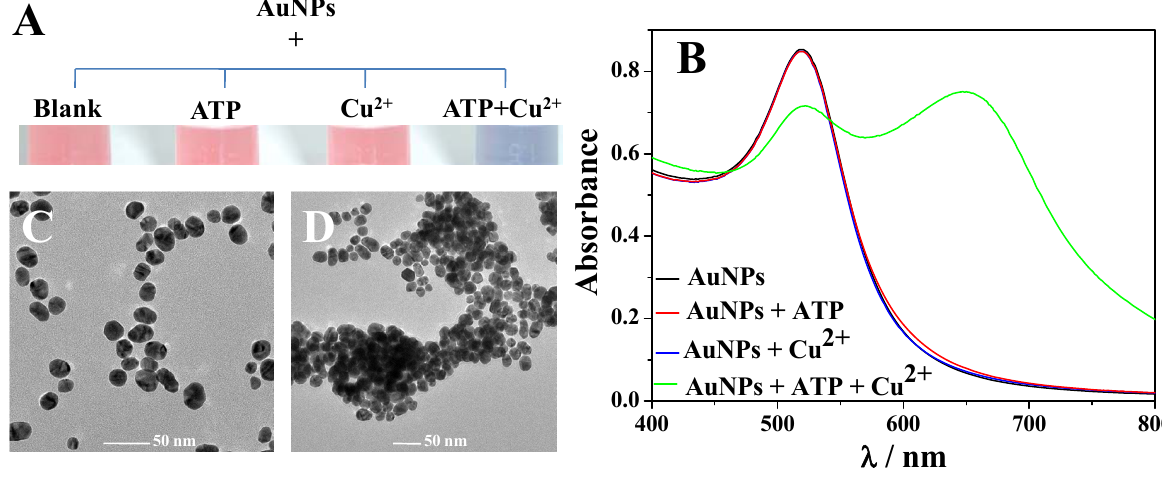
Figure 2. Visual color change ( A ), UV/Vis absorption spectra ( B ) and TEM images ( C , D ) of AuNPs in the absence and presence of ATP and/or Cu 2+ . The concentrations of ATP and Cu 2+ are 15 and 30 μ M,